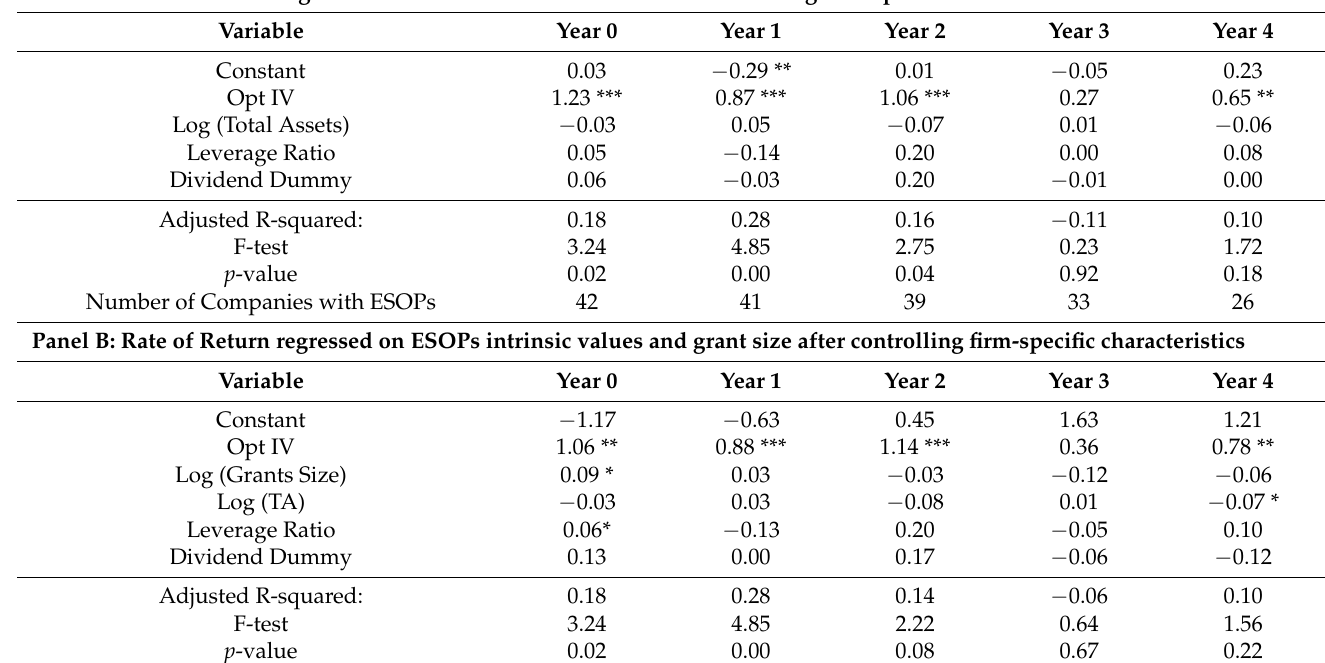
Table 7. ESOPs and stock returns. This table describes the rate of return as a proxy for firm performance, which is used as a further robustness test. The results of a regression of the rate of return on Opt IV as a proxy for the ESOPs intrinsic value are presented in Panel A. Grant Size is the natural logarithm of option grants owned by executives in Panel B. Panel C depicts the result of the rate of return after controlling for firm-specific characteristics and industry effects. Leverage Ratio is a proxy for firm leverage; Dividend Dummy is a proxy for overinvestment problems; and the natural logarithm of total assets is a proxy for firm size, as shown in this table. T-statistics are listed under the coefficients of the variables. Industry dummy variables are a proxy for industry effects. The table also describes the adjusted R-square, F-test and p -value at the bottom of the table. Year 0 reflects the year of the first ESOPs issuing; and Year 1 to Year 4 represent the years after the issuing. *, ** and *** indicate 90%, 95% and 99% levels of significance,